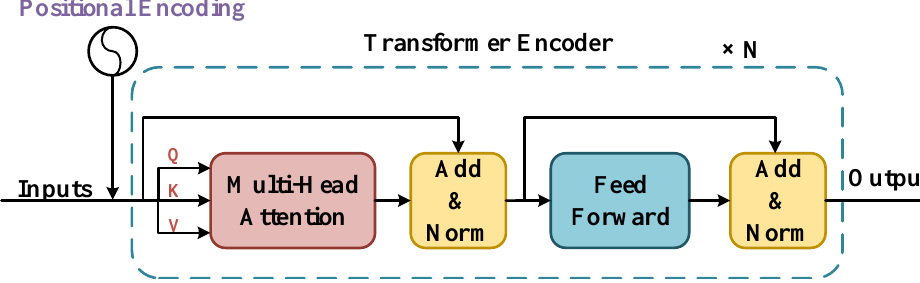
Figure 2. The structure of the Transformer Encoder employed to extract temporal information of sequences. After the data processed, the data are fed to the Transformer Encoder to extract temporal information. A single Transformer Encoder layer is composed by a Multi-Head Attention module and a Feed-Forward module with an external Positional Encoding